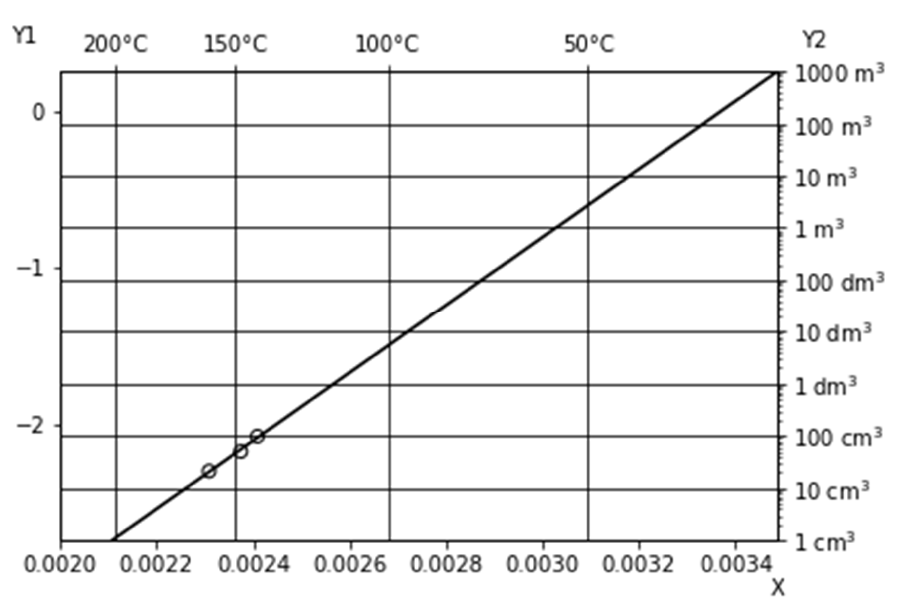
Figure 9. The temperature of sludge pellets in a 98.17 cm 3 basket: ( a ) at a furnace temperature of 160 °C with no evidence of dust ignition, ( b ) at a furnace temperature of 162 °C with a dust ignition. The temperature of sludge pellets in different sample baskets and the furnace temper- ature are presented in Figures 7–9. A pseudo-Arrhenius graph of the sludge-dust spontaneous-combustion temperatures is shown in Figure 10. A line through the T SI values separates areas representing stable (below the line) and unstable (above the line) dust volume behavior. Self-ignition of the sludge dust occurs in the area above the line.